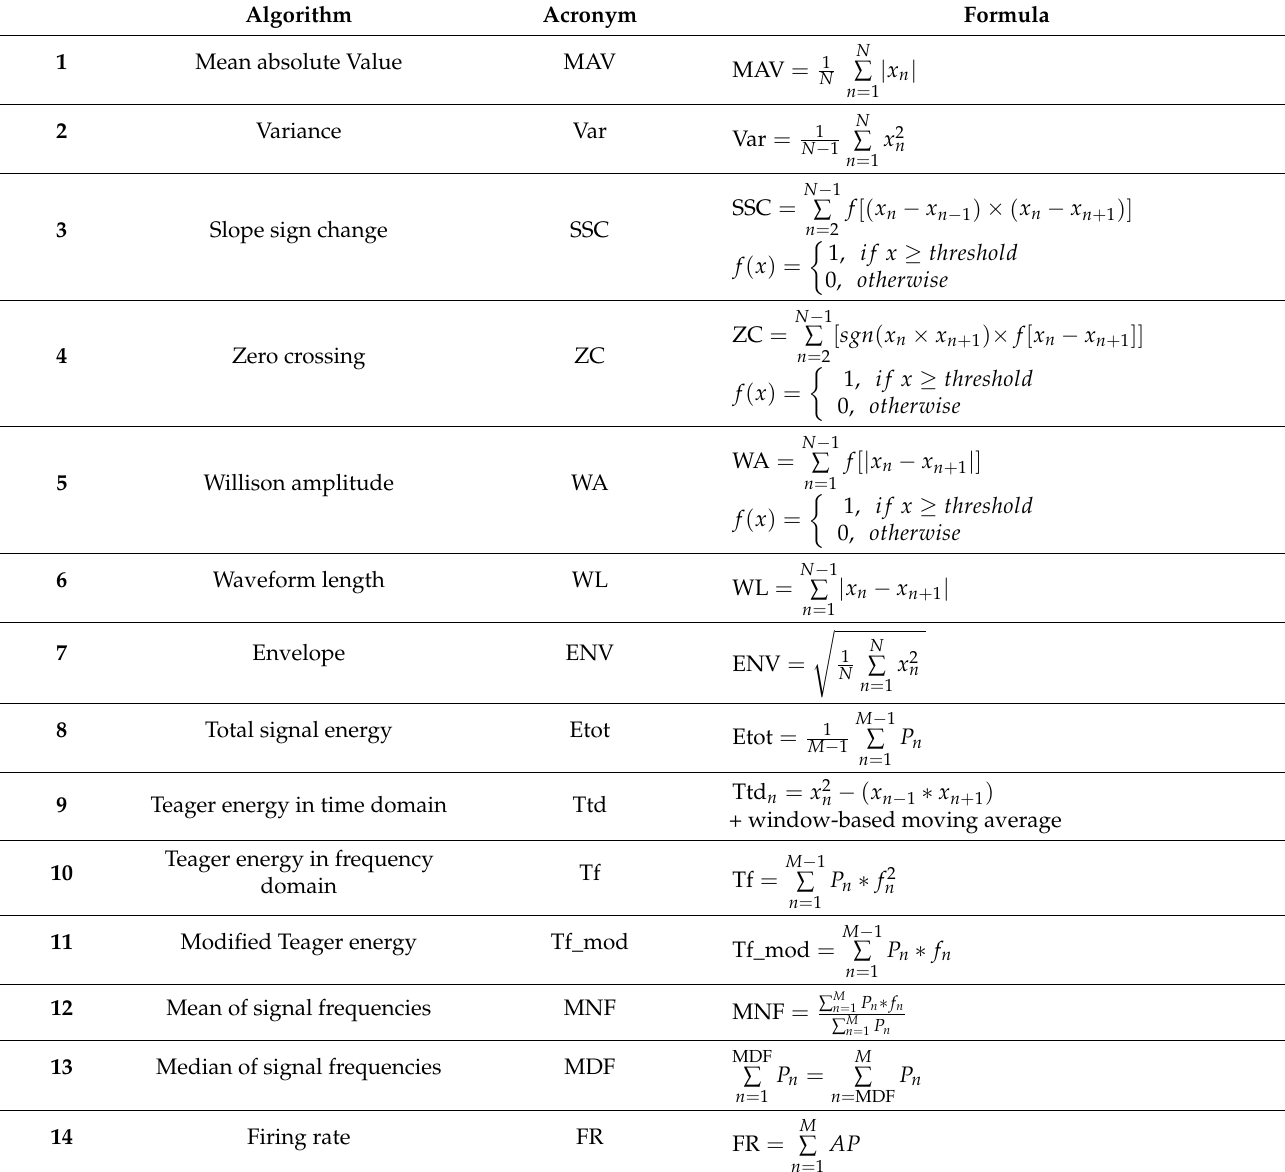
Table 1. Formulas used to compute algorithms that were evaluated. N denotes window length, x n is the n -th iEMG sample within the current window, M is the number of frequency bands, P n is the spectral power of the n-th frequency band, f n is the central frequency of the n-th frequency band, and AP the number of detected action potentials over the threshold within the sliding window